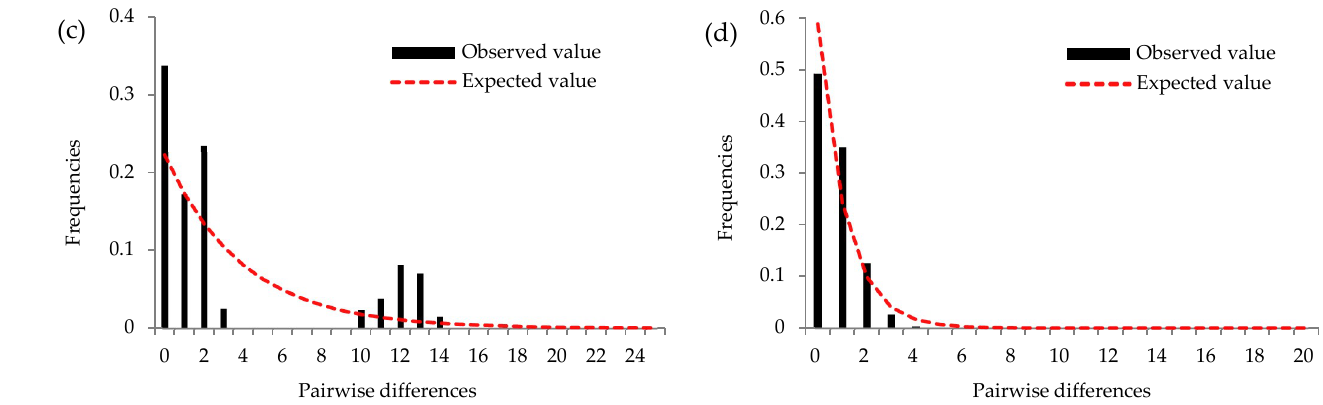
Figure 8. Mismatch distributions of pairwise nucleotide differences between individuals of R. maidis and R. padi . ( a ) Combined COI-COII gene of R. maidis ; ( b ) EF-1 α gene of R. maidis ; ( c ) combined COI-COII gene of R. padi ; ( d ) EF-1 α gene of R. padi . The numbers of pairwise differences are on the